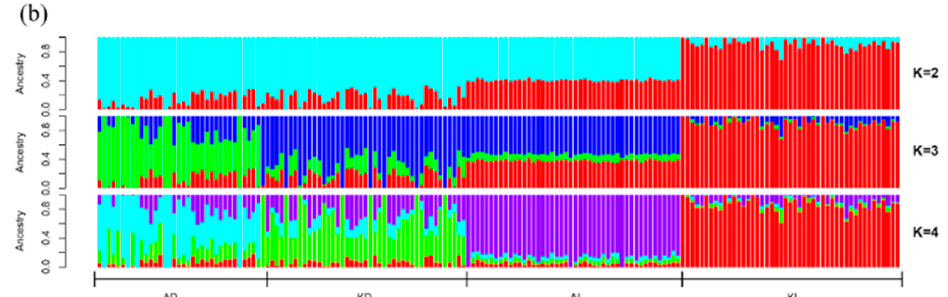
Figure 1. Population genetics analysis. ( a ) Principal components analysis (PCA) plot of four breeds, indicating genetic variation along the PC1 and PC2. The dots represent Aldabas (blue), Kurdyuchnyj (red), Karakul (yellow) and Aletai (black). ( b ) Population assignment proportions per individual based on results from ADMIXTURE analysis (K = 2 to K = 4). In the plot, each vertical bar represents a single individual, and the different colors reflect the genetic contribution from each of the components. ( c ) The decay of linkage disequilibrium in each breed, the r 2 is the mean of the r 2 in 50 kb windows.